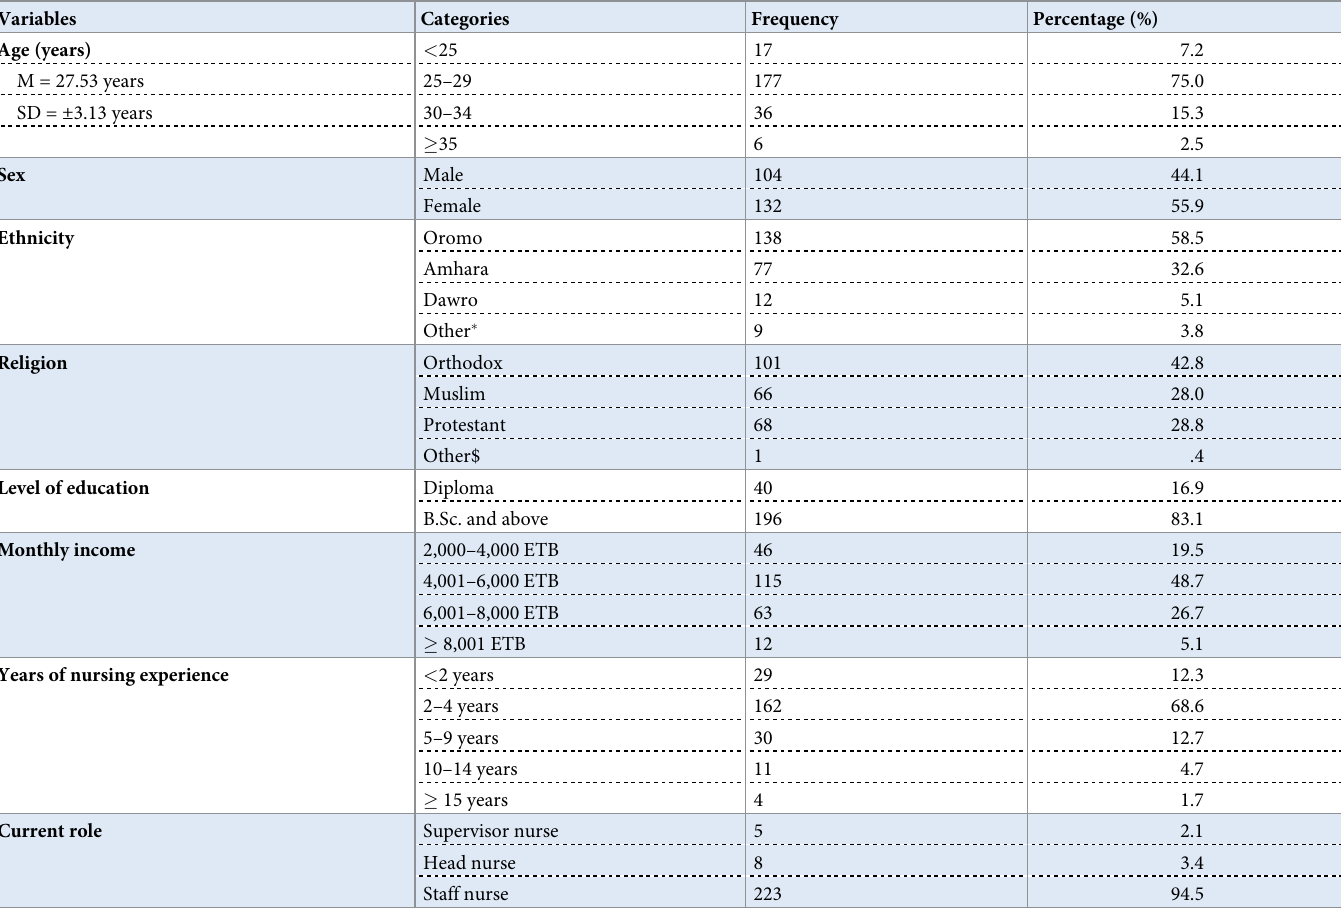
Table 1. Socio-demographic characteristics of nurses working at JMC, Oromia Region, Southwest Ethiopia, May to June 2020 (n = 236). Variables